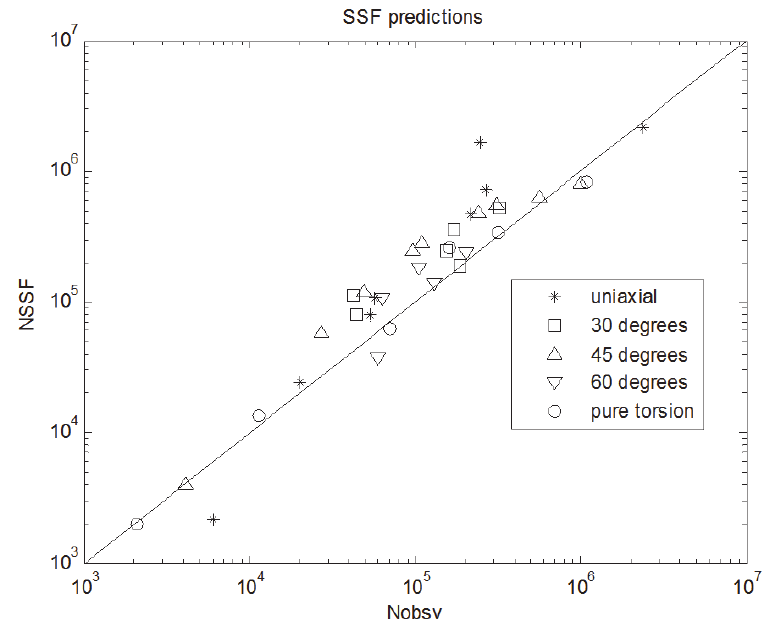
Figure 1: Comparison between the observed fatigue lives N obsv and the fitted N SSF